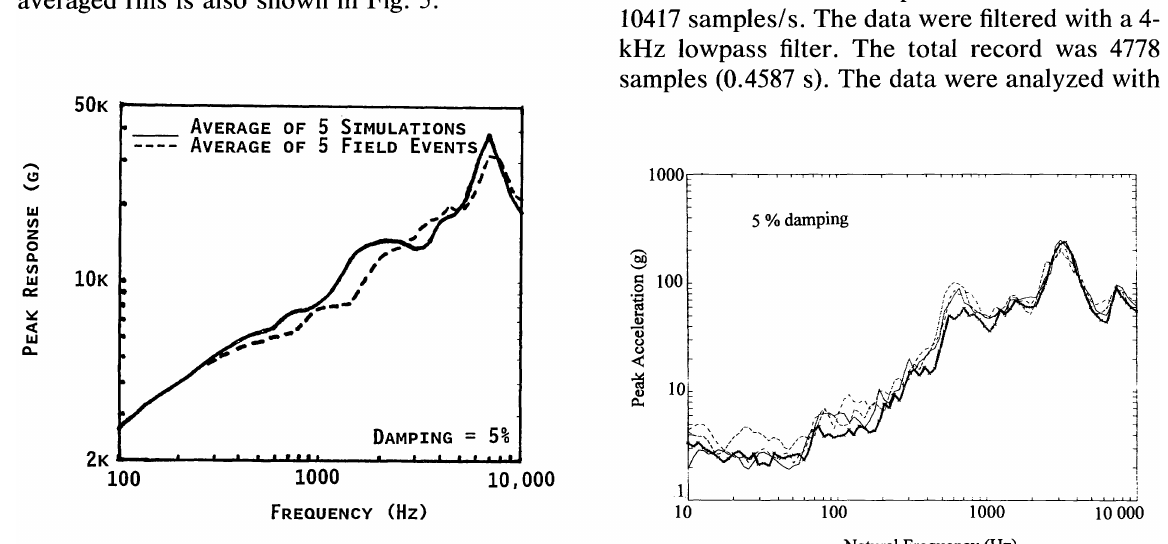
FI~URE 4 Comparison of the SRS, the mean pene tration event, and the average SRS of five penetration simulations.